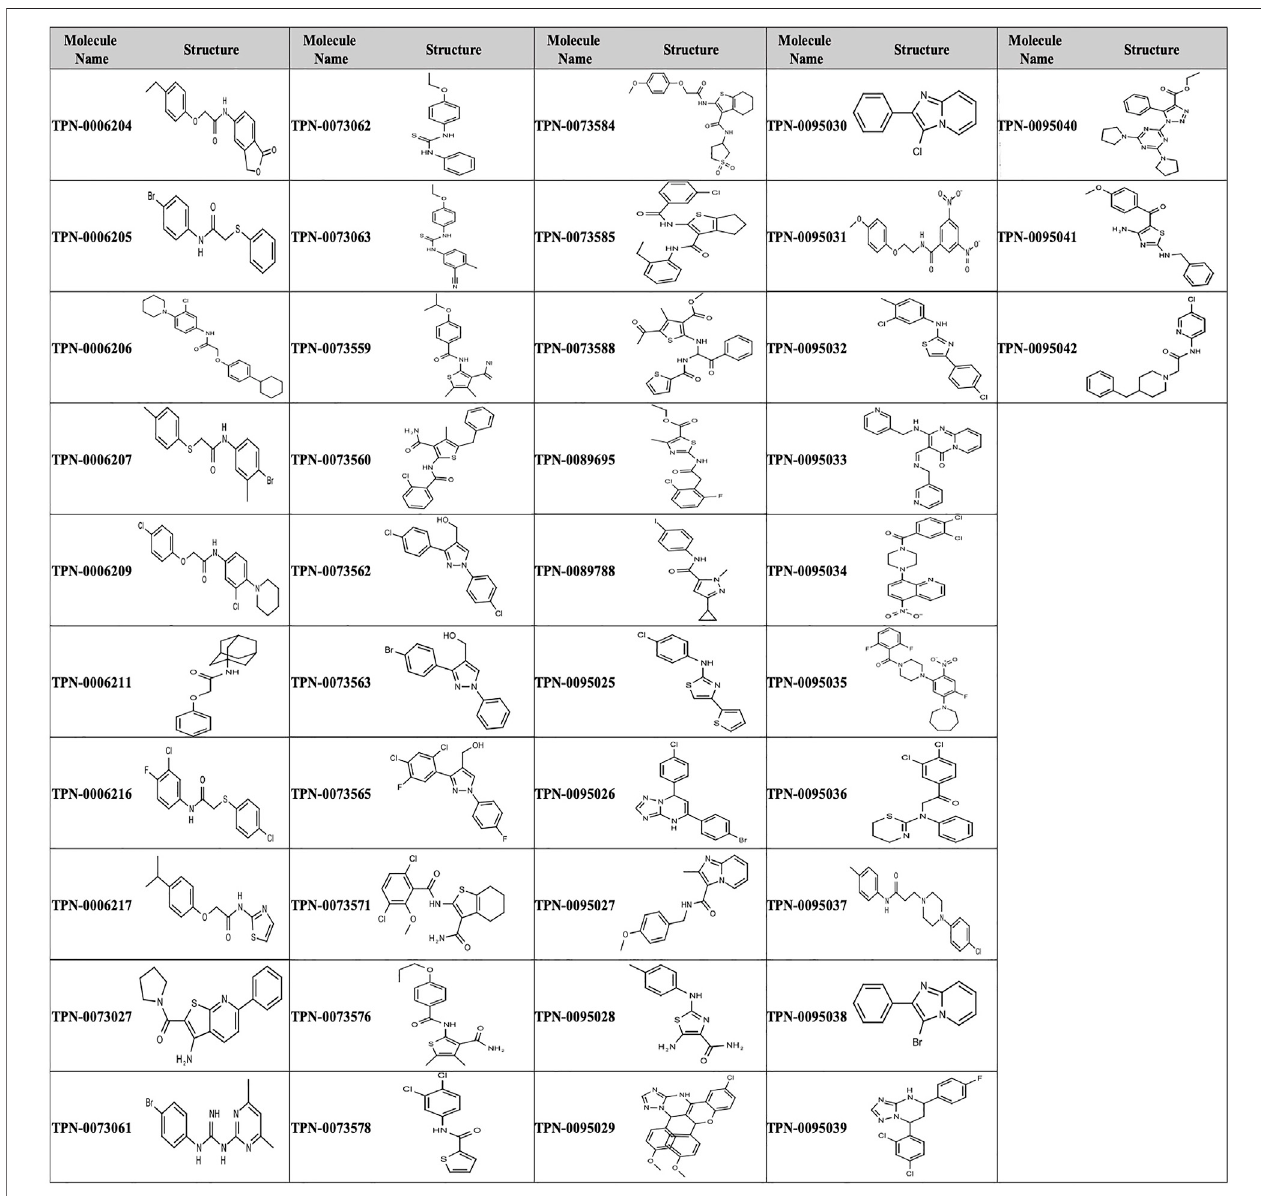
FIGURE 3 | Structure of primary hits selected for follow